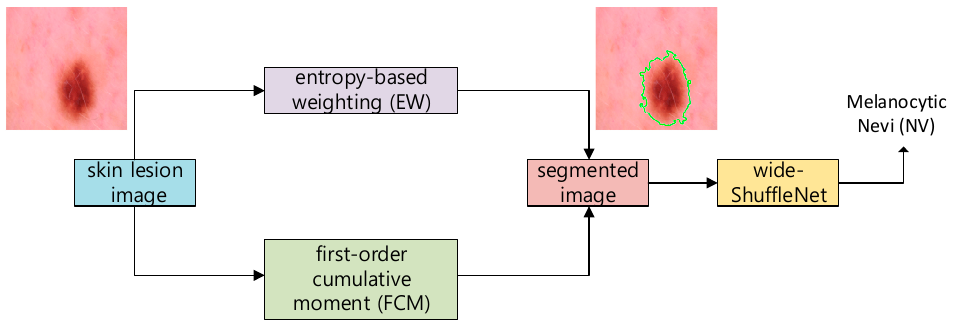
Figure 1. Structures of the proposed method.